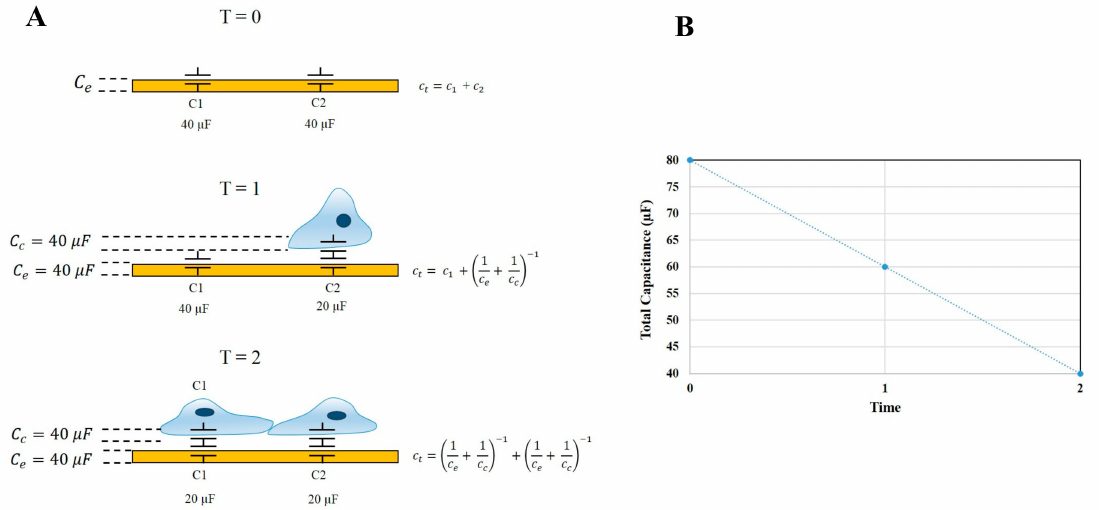
Figure 2. Diagrammatic description of ECIS-Z θ capacitance theory. ( A ) The attachment and cell growth over an ECIS electrode over time. At T = 0 the total capacitance (C T ) of the system is equal to the sum of the electrode capacitance (C e ) in parallel. As cells progressively adhere to the surface electrodes, an increasing proportion of C T is represented by the cell-electrode capacitance (C c ). The cell-electrode capacitance can be interpreted as capacitors connected in series; ( B ) Graphical representation of the change in total capacitance over time, as cells adhere to and cover exposed electrode